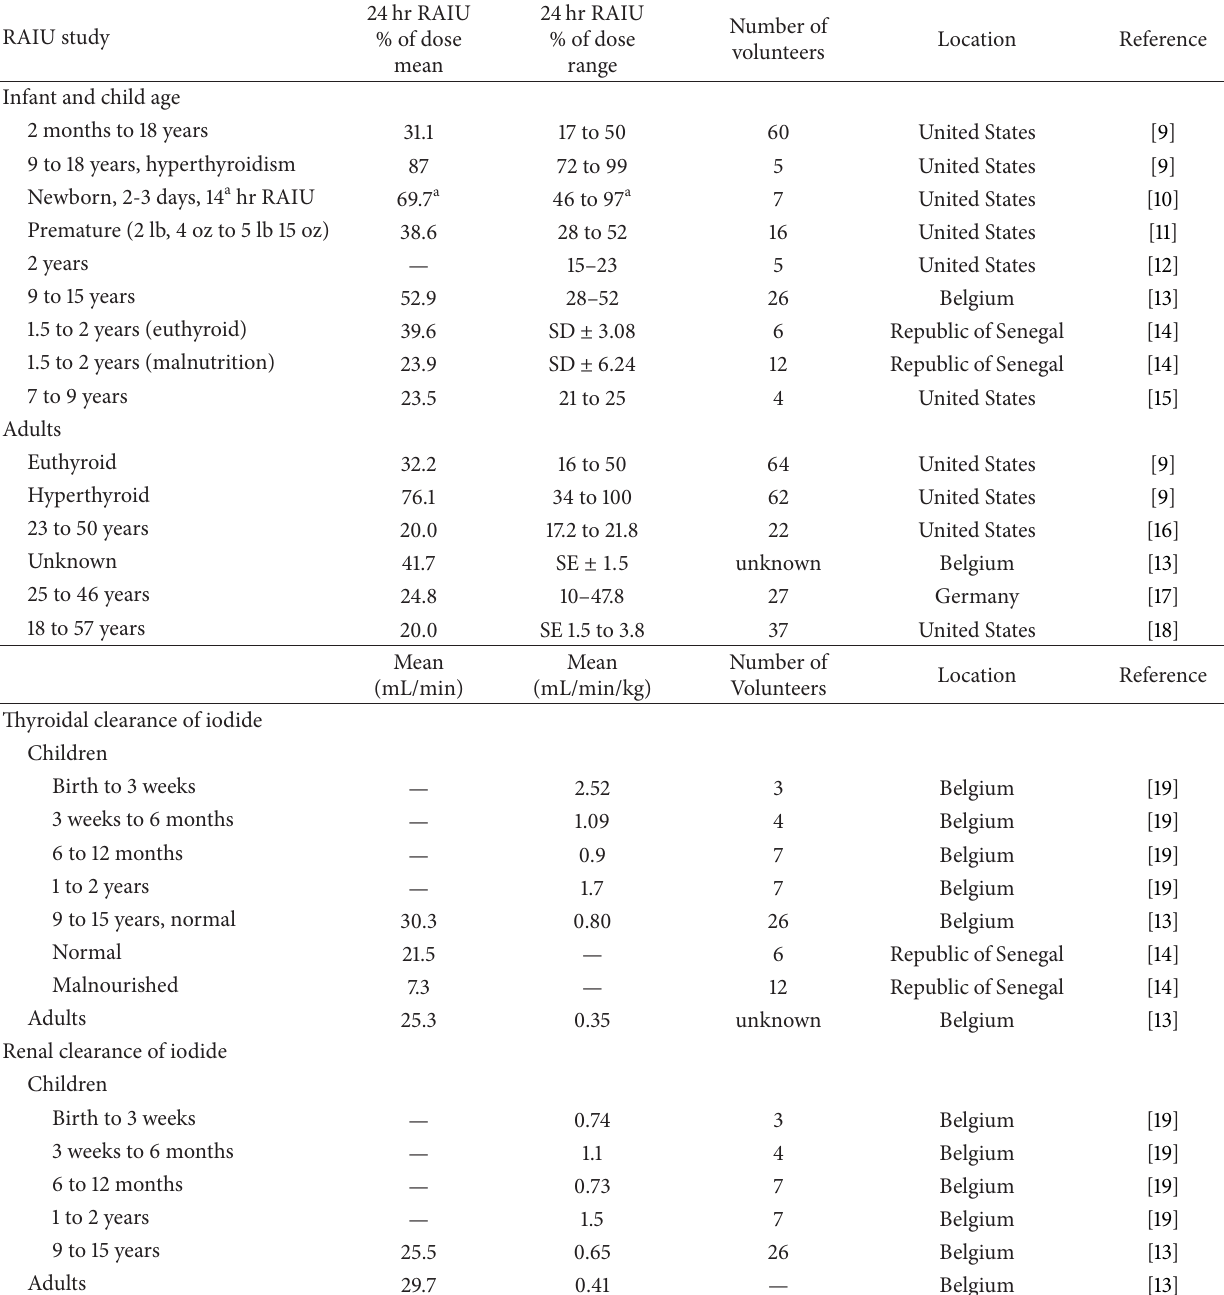
Table 2: Radioactive iodide uptake into the thyroid gland (RAIU, expressed as percent of the administered radioactive dose) and thyroidal and renal clearance rates of iodide in infants, children, and